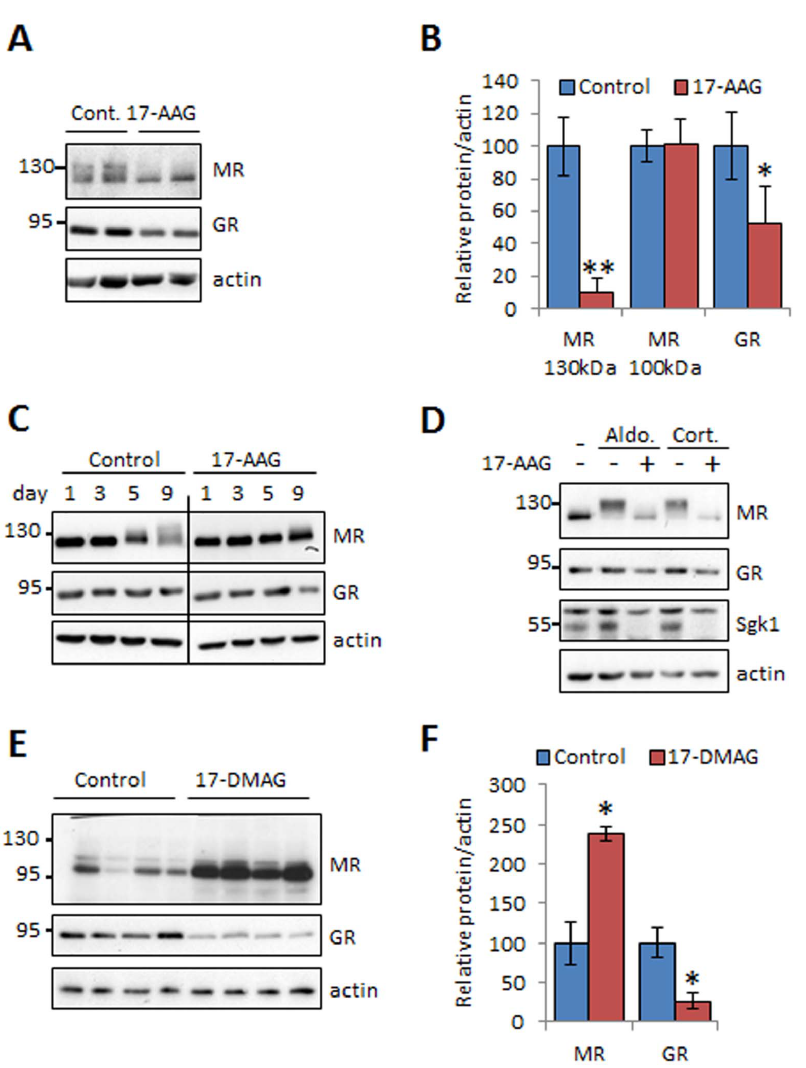
Figure 4. Geldanamycin analogues affect glucocorticoid receptors expression. (A to C) 3T3-L1 preadipocytes were induced to differentiation with or without 17-AAG (100 nM) for 10 days. (A and B) Cell lysates were analyzed by immunoblotting using antibodies against MR, GR and actin asa loading control. (B) The MR and GR expression level was quantified and values were normalized to actin and displayed as mean 6 SD (n=3), *p , 0.05, **p , 0.01. (C) 3T3-L1 preadipocytes were induced to differentiation and lysed at indicated day with or without 17-AAG treatment (100 nM) for 24 h. (D) Preadipocytes were treated with aldosterone (10 nM) or corticosterone (10 nM) with or without 17-AAG (100 nM) for 3 h before lysis. Cell lysates were then analyzed by immunoblotting using antibodies against MR, GR, and actin as a loading control. (E) White adipose tissue lysates from HFD or HFD + 17-DMAG mice were submitted to immunoblotting using antibodies against MR, GR and actin as a loading control. (F) The protein expression levels were quantified and values are given as mean 6 SEM (n=7 HFD, n=8 HFD + 17-DMAG), *p , 0.05.